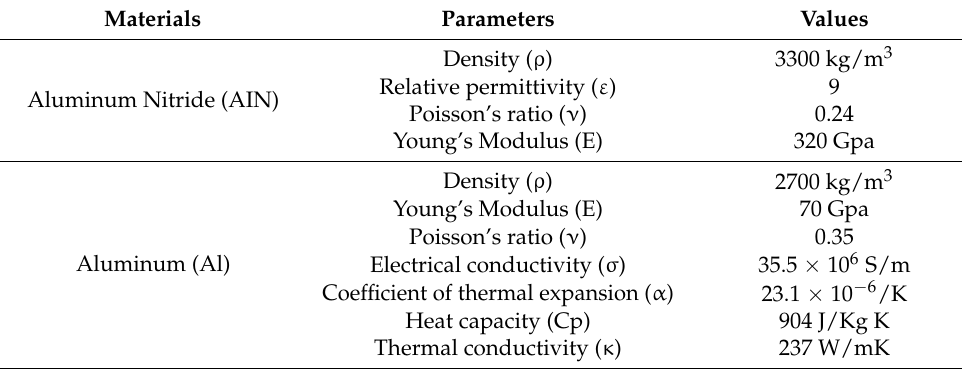
Table 4. Parameters of Al and AlN